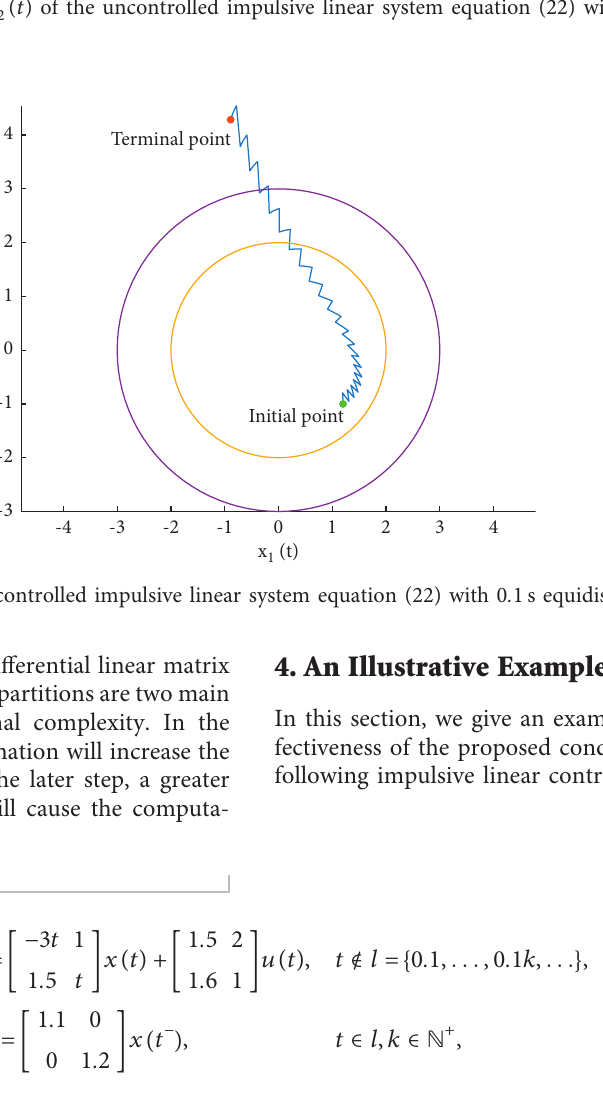
( t ) and x ( t ) of the uncontrolled impulsive linear system equation (22) with 0 . 1s equidistant impulsive 1 2